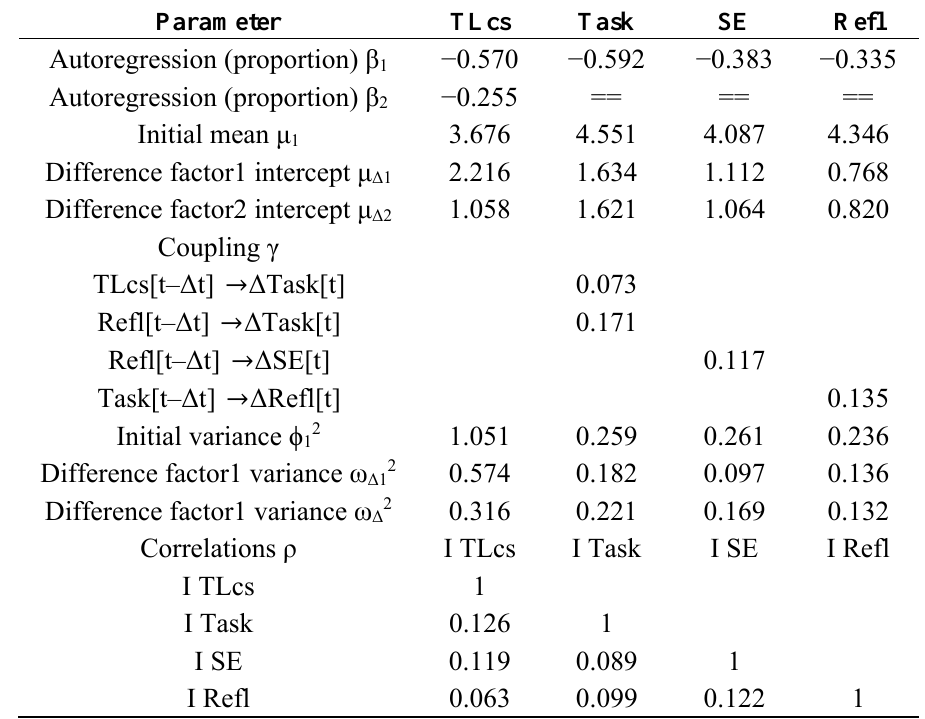
Table 1. Parameter estimates from the final multivariate latent proportional change score